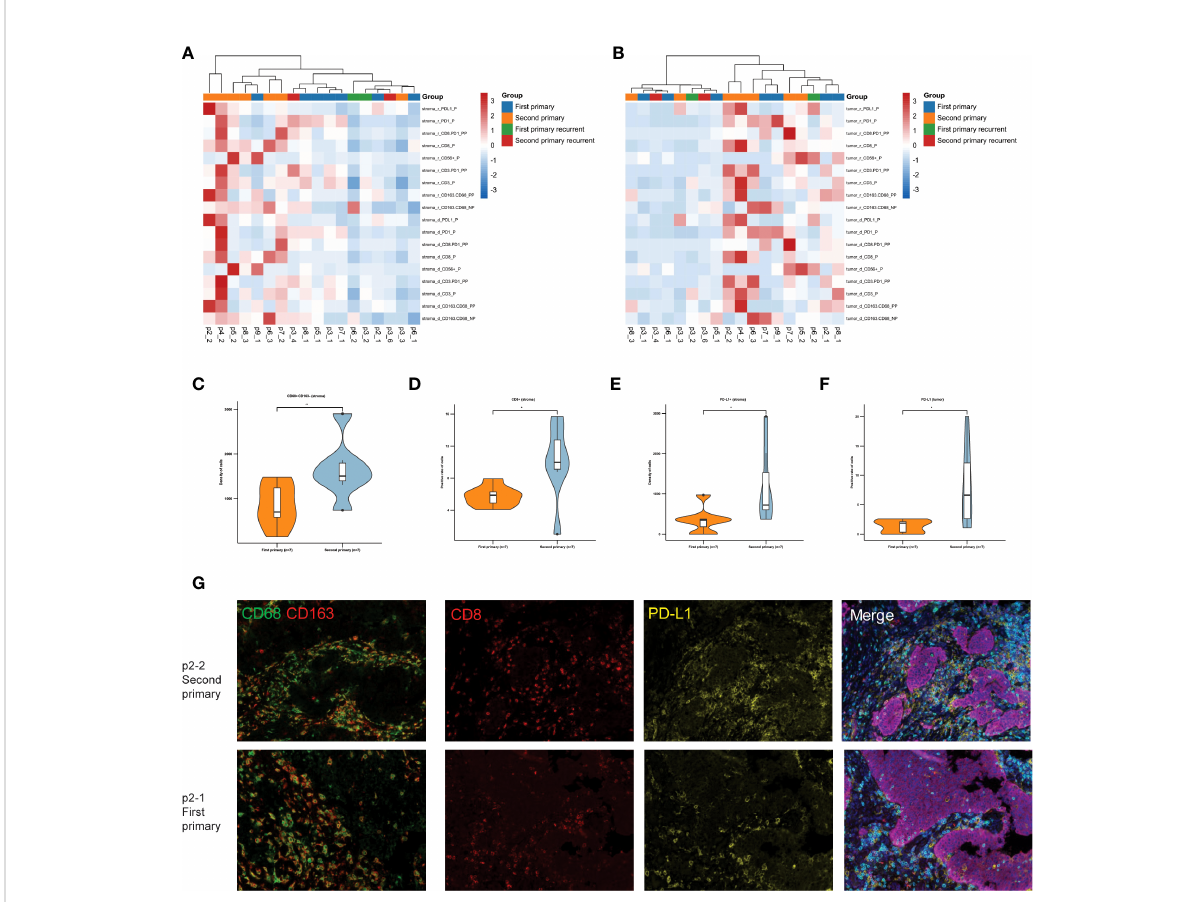
FIGURE 5 TME analysis of tumors with similar and different clonal origins. (A) The heat map shows the density and positive cell rate of seven key immune markers, PD1, PD-L1, CD3, CD8, CD56, CD 68, and CD163, in the stroma of patients with recurrence. (B) The heat map shows the density and positive cell rate of seven key immune markers in tumor of patients with recurrence. (C) The density of CD68 + CD163- sTILs in fi rst primary group and second primary group. (D) The positive cell rate of CD8+ sTILs. The density of PD-L1+ sTILs (E) and iTILs (F) in fi rst primary group and second primary group. (G) Representative immuno fl uorescence micrographs of primary tumors (lower panels) and second primary tumors (upper panels) in p2. Double staining of CD68 (green) and CD 163 (red) shown on the left panels. Merged image of CD8 (red), PD-L1 (yellow), PD1 (green), PD-L1 (yellow), CD3 (indigo), pan-Cytokeratin (purple) and DAPI (blue) shown on the right panels. Original magni fi cation ×100. *, p ≤ 0.05; **, p ≤